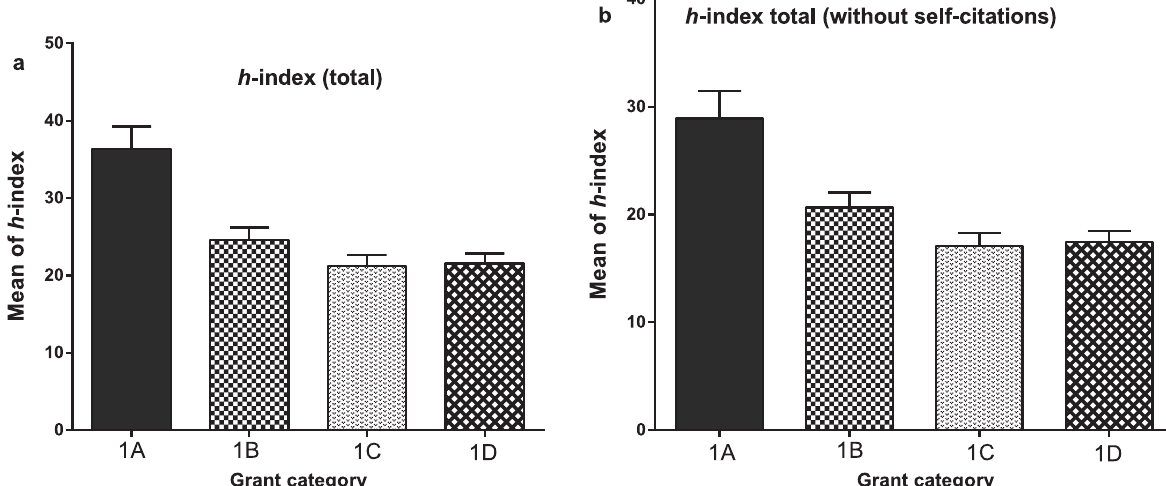
Figure 3 - Total h -index with (a) and without self-citations (b) of Brazilian researchers from CNPq grant category 1A-D in